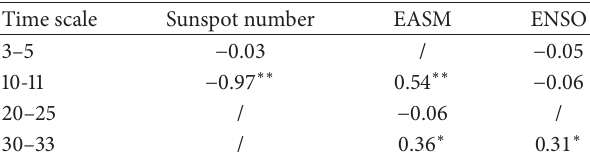
Table 4: Correlations between Liaoning annual precipitation, sunspot number, East Asian Summer Monsoon (EASM), and Global-SST ENSO index (ENSO) at the four primary cycles